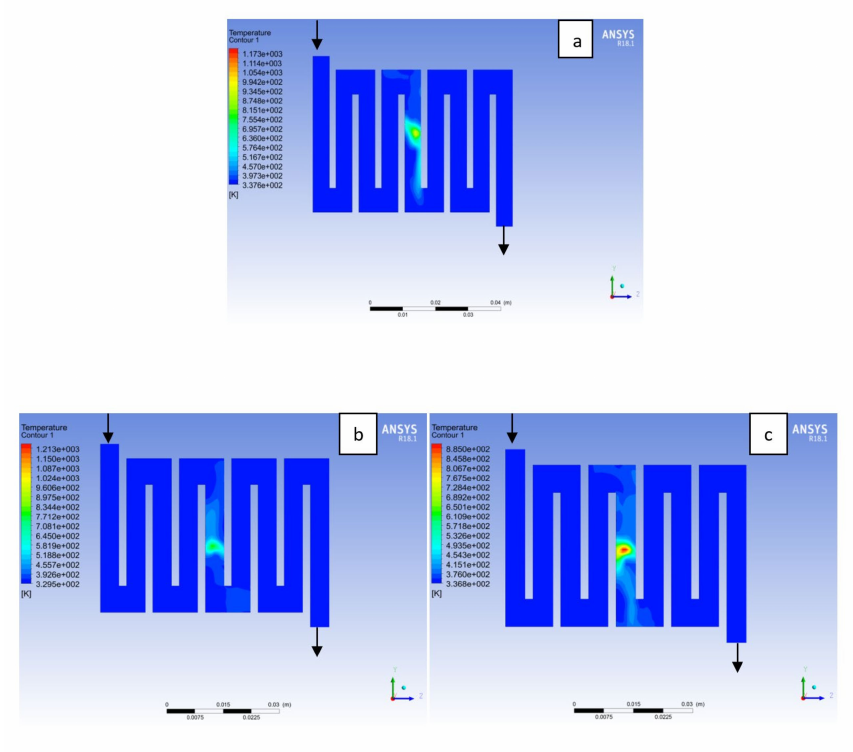
Figure 8. Temperature distribution at the cathode region (GDL/CL) for each materials at 338K: ( a ) Aluminum, ( b ) Copper, ( c )